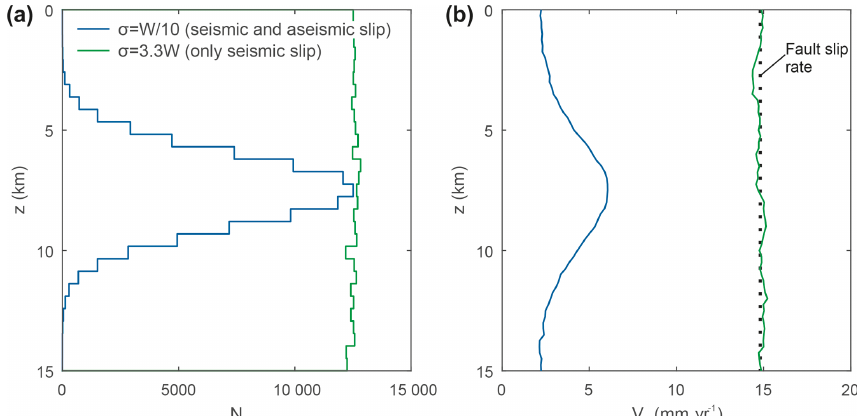
Figure 3. Depth distribution of earthquakes, seismic and aseismic slip. (a) Depth distribution of the number N of mainshocks for the two models considered here. The depth distribution is a normal one centred at a 7.5km depth and with a variance σ equal to W/ 10 (blue) or 3 . 3 W (green). (b) Depth distribution of seismic V S slip. The vertical black line indicates the averaged fault slip rate of ∼ 15mmyear − 1 , summing seismic and aseismic slip. Aseismic slip rate is simply the difference between the average fault slip rate and seismic slip rate, so that all models share the same total slip